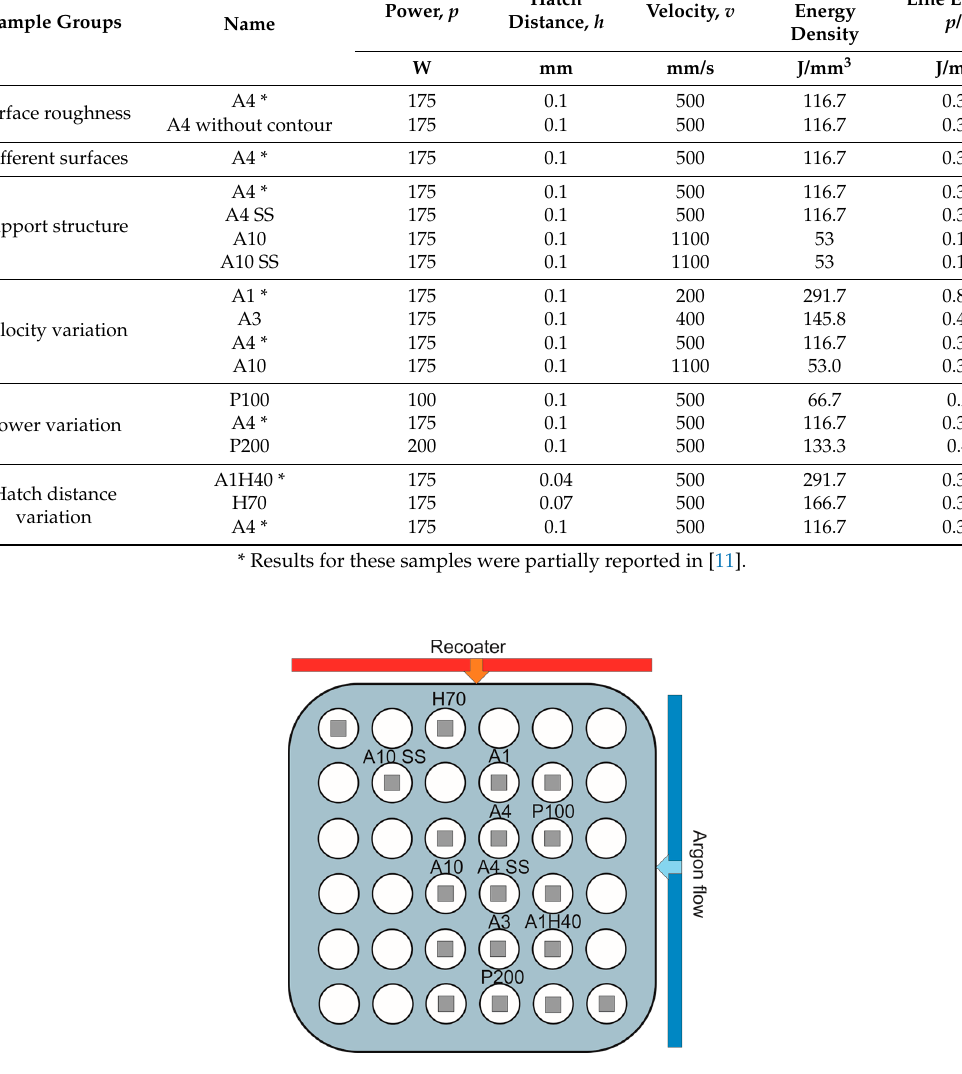
Figure 1. Schematic position of the samples in the build chamber. Table 1. Processing parameters.